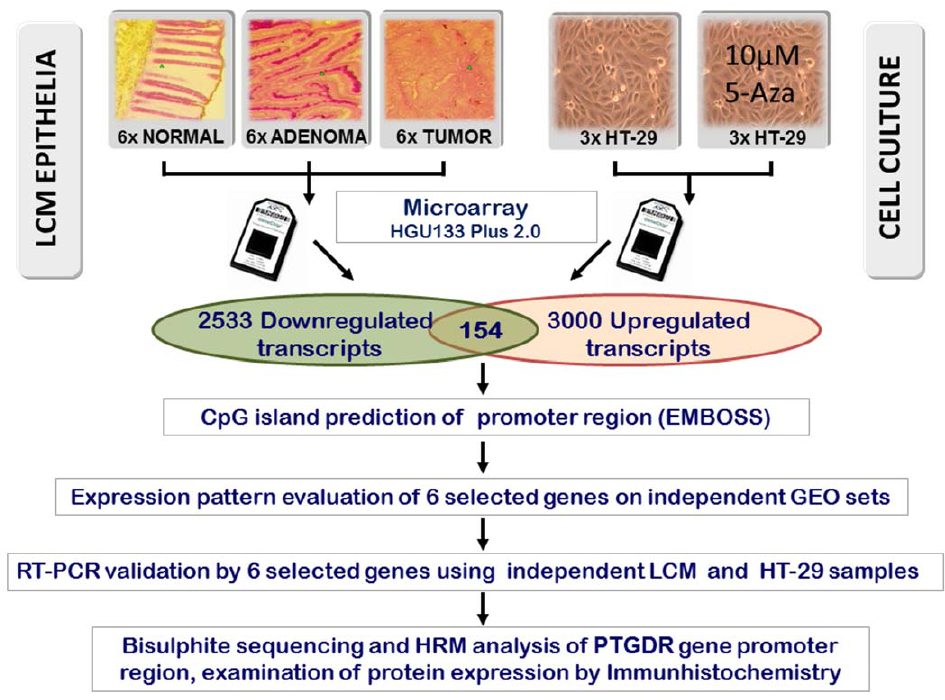
Figure 1. Experimental design.